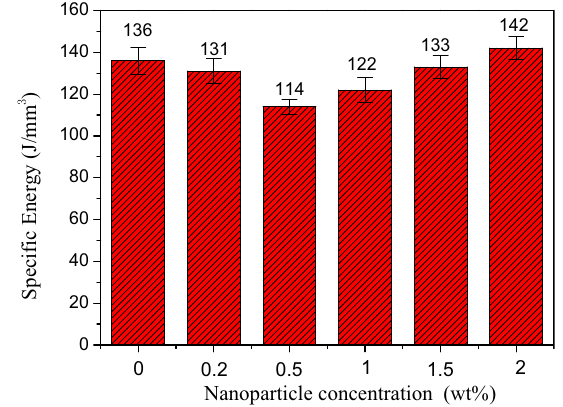
Figure 3 Specific energy obtained using different Al 2 O 3